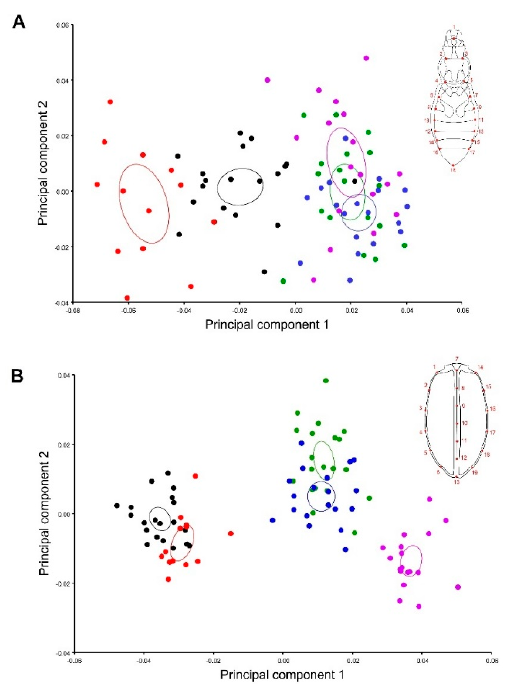
Figure 2. Principal component analysis of the ventral ( A ) and elytral ( B ) shape variation between multiple ground beetle species. The graphical visualization represents the shape space for the five species represented by colors: Red: Carabus exaratus , Black: Carabus granulatus , Green: Pterostichus melanarius , Blue: Pterostichus niger , Purple: Pterostichus oblongopunctatus . * Each point represents a different shape.